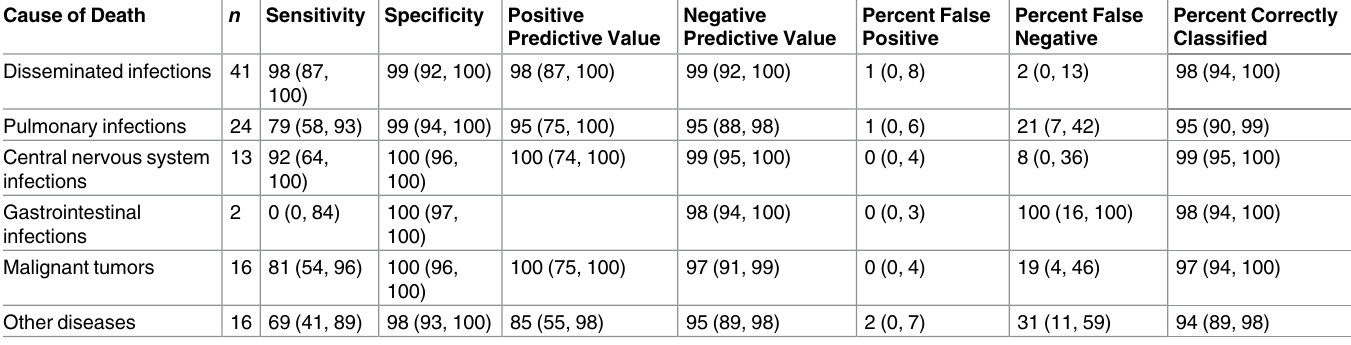
Table 4. Sensitivity, specificity, and positive and negative predictive values and percentage of false-positive and false-negative diagnoses and cases correctly classified by the minimally invasive autopsy. Cause of Death n Sensitivity Specificity Positive